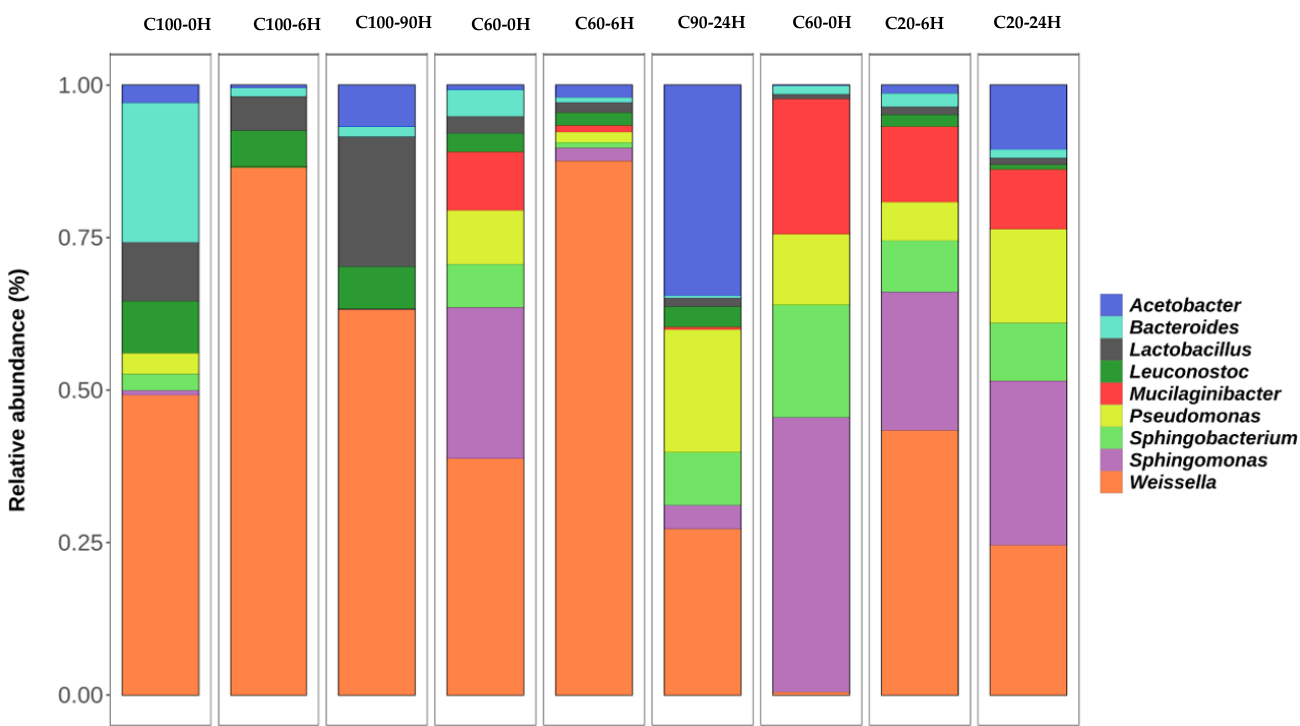
Figure 8. Relative abundance of the main bacterial genera of cactus forage and buffel grass hay levels at different times of exposure to air. T1 = 100% cactus forage; T4 = 60% cactus forage and 40% buffel grass hay; T5 = 20% cactus forage and 80% buffel grass hay; 0H = 0 h; 6H = 6 h and 24H = 24 h of exposure to air.